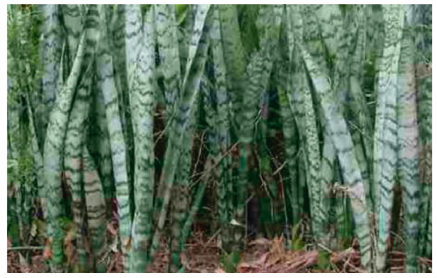
Figure 1: Sansevieria trifasciata plant. Table 1: List of prepared